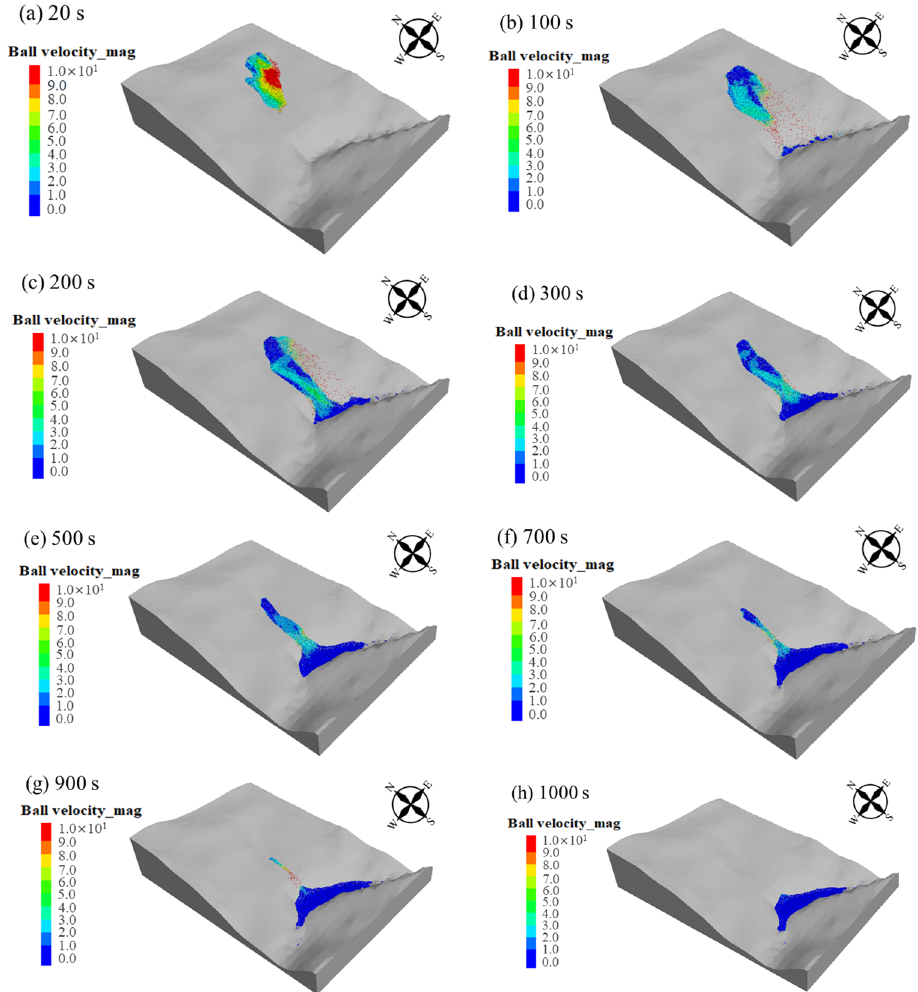
Figure 12. Dynamic process of the Shaziba landslide (velocity nephogram): ( a ) t = 20 s; ( b ) t = 100 s; ( c ) t = 200 s; ( d ) t = 300 s; ( e ) t = 500 s; ( f ) t = 700 s; ( g ) = 900 s; ( h ) t = 1000 s.